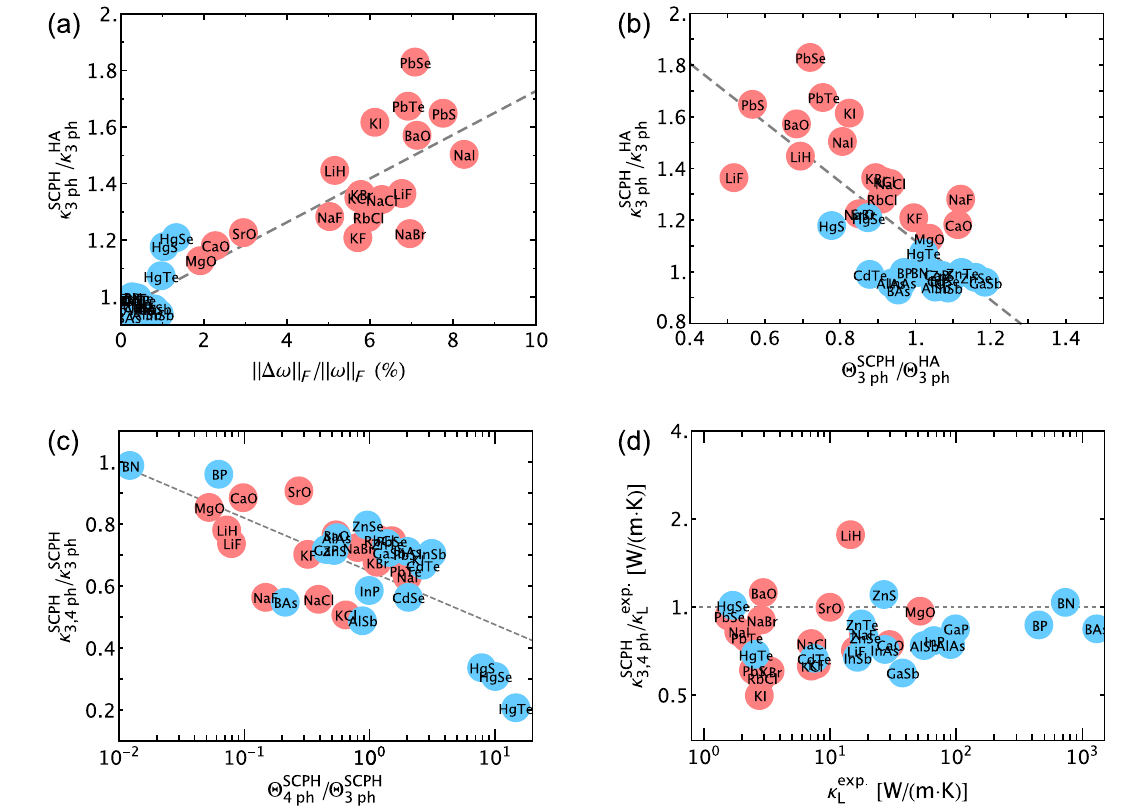
FIG. 4. Correlation between the lattice thermal conductivity and the phonon scattering phase space for the selected binary = jj ω jj rocksalts (red disks) and zinc blendes (blue disks). (a) Ratio of κ SCPH 3 to κ HA 3 plotted as a function of the ratio jj Δ ω jj . F F ph ph to κ HA 3 plotted as a function of the ratio of Θ SCPH 3 to Θ HA 3 , wherein Θ denotes phonon scattering space (see (b) Ratio of κ SCPH 3 ph ph ph ph Appendix B for the definition). (c) Ratio of κ SCPH 3 to κ SCPH 3 plotted as a function of the ratio of Θ SCPH 4 to Θ SCPH 3 . (d) Ratio of κ SCPH 3 to ; 4 ph ; 4 ph ph ph ph κ exp = κ exp plotted as a function of experimental lattice thermal conductivity κ exp . The ratio κ SCPH 3 is obtained by dividing the L L L ; 4 ph theoretical value by the highest experimental value, both listed in Table I. The gray dashed lines in panels (a) – (c) represent the linear fit of the data, in line with the coordinate system, while in panel (d), the line denotes equal values between theory and experiment. All calculations are performed at 300